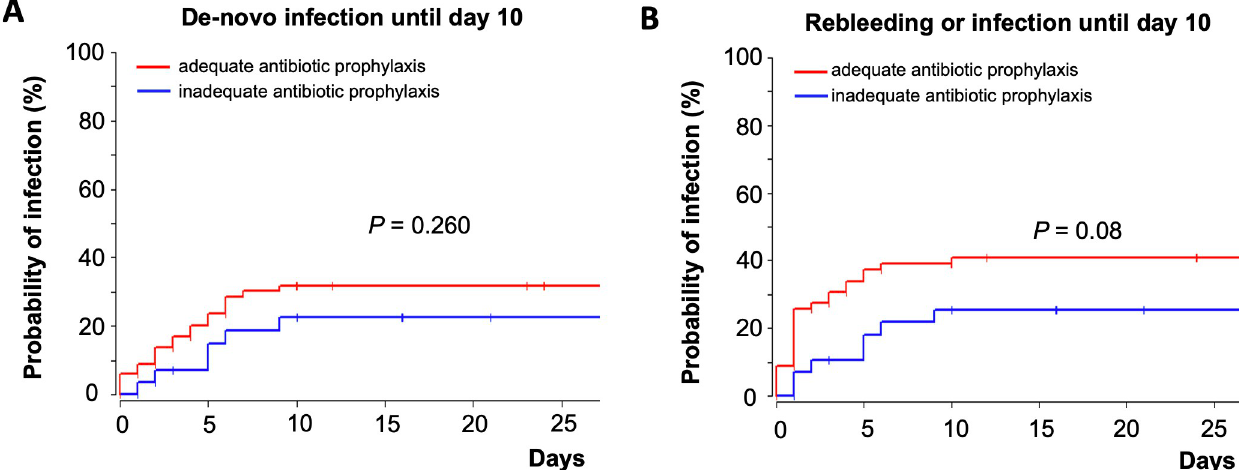
Fig 2. Kaplan-Meier curve depicting time-to event analysis in patients with adequate and inadequate antibiotic prophylaxis following the bleeding event with regards to de-novo infection until day 10 (A) and the composite outcome of rebleeding or infection until day 10 (B).